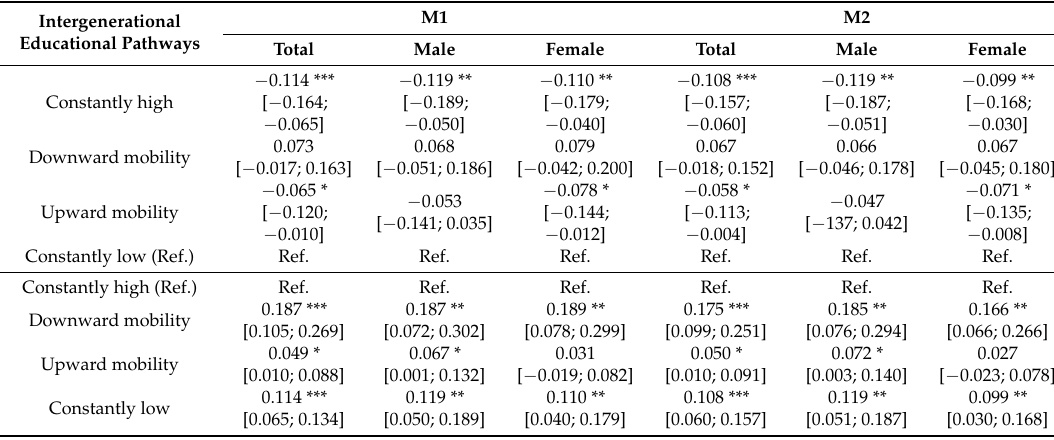
Table 2. AME based on logistic regression analysis of the relationship between fair/poor SRH of young adults and intergenerational educational pathways (Ref. constantly high education and constantly low